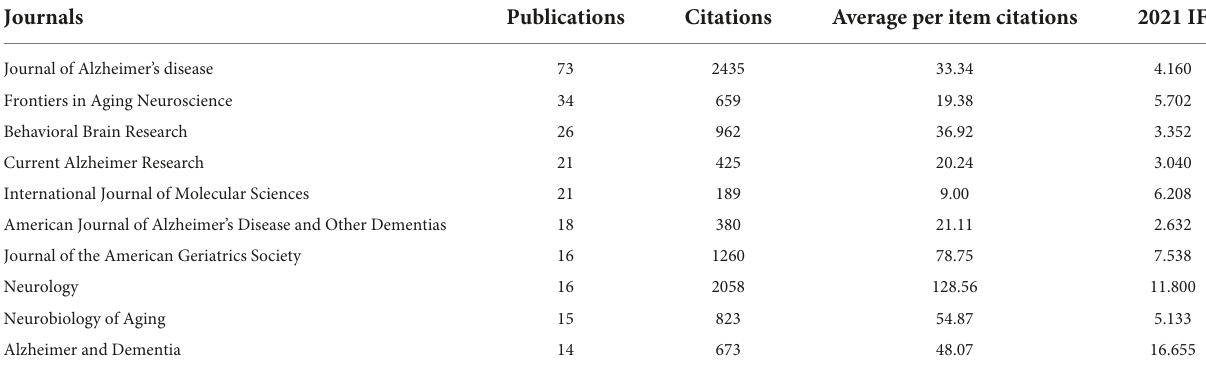
TABLE 4 Top 10 most productive